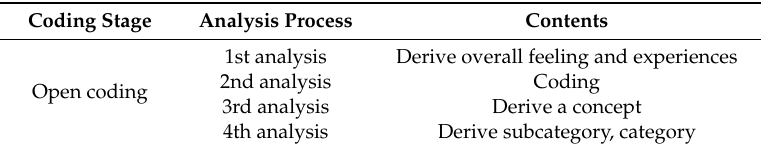
Table 1. Four stages of the open coding